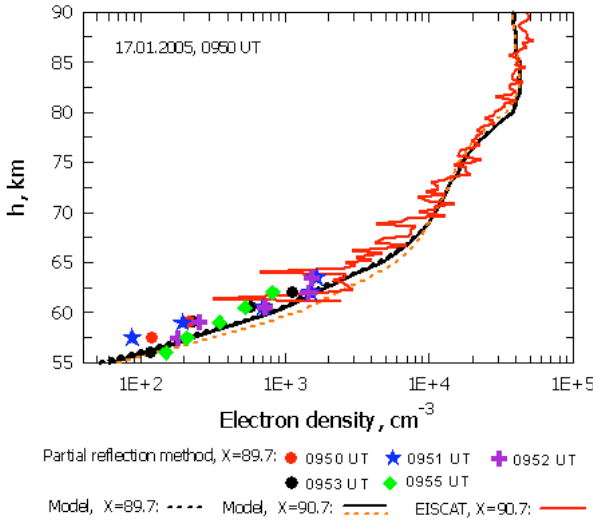
Fig. 6a. Electron density profiles measured by EISCAT radar (red curve) and calculated for the SPE on 29 October 2003 at 10:00UT for zenith angle 84.7 ◦ and 90.7 ◦ (black curve)using the O, O 3 and NO profiles 4–6 in Fig. 1. Red dashed curve using the O, O 3 and NO profiles 1–3 in Fig. 1.